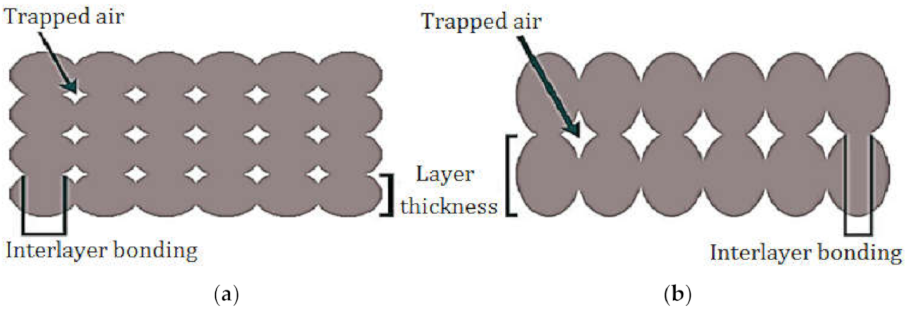
Figure 7. Interlayer bonding and trapped air using ( a ) lower LT and ( b ) higher LT.